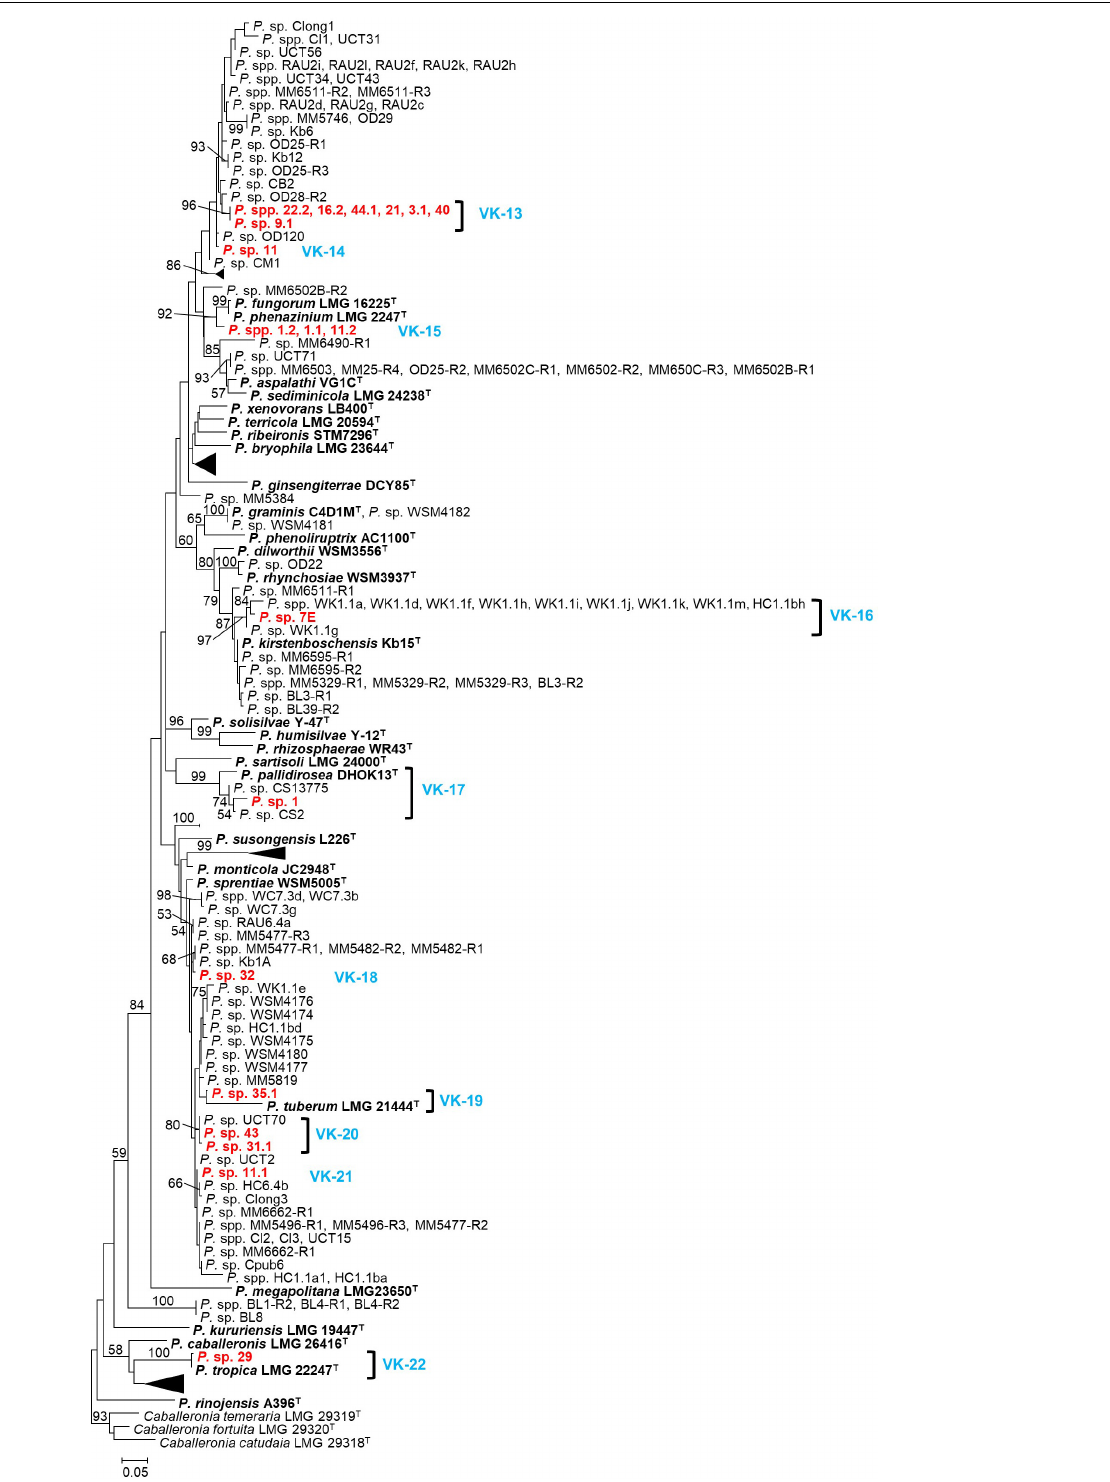
Frontiers in Microbiology |